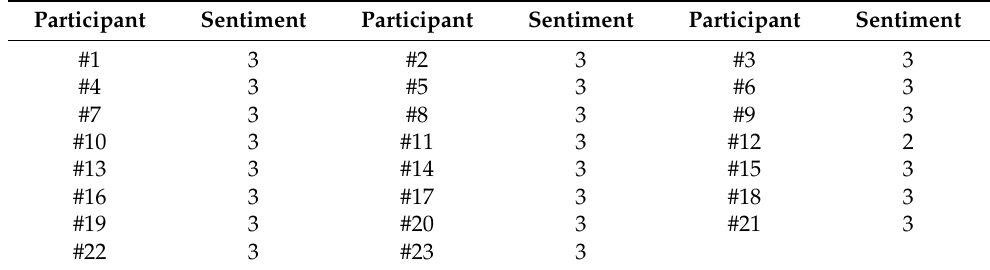
Table 2. Assessment scores per user.